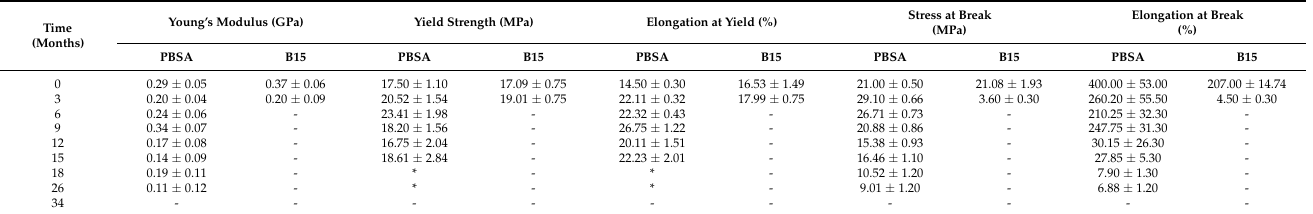
Table 3. The tensile properties of the PBSA and B15 composites during the biodegradation test in a seawater tank. Mean values ± standard deviation of 3